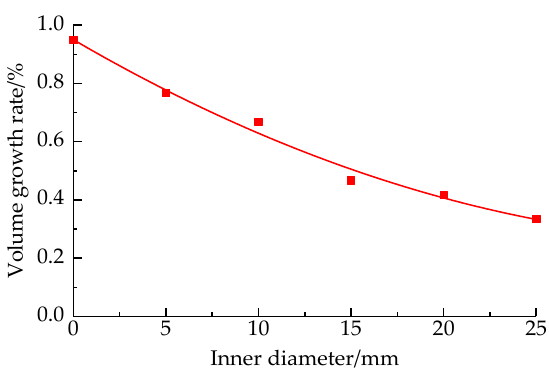
Figure 4. Volume growth rate changes with annular diameter change. The volume growth rate of ring sandstone specimens decreases with the increase in inner diameter. The fitting results show a quadratic function where the inner diameter of the ring specimen is with the volume growth rate, and the correlation coefficient reaches 0.9808. The fitting formula is shown in (2).